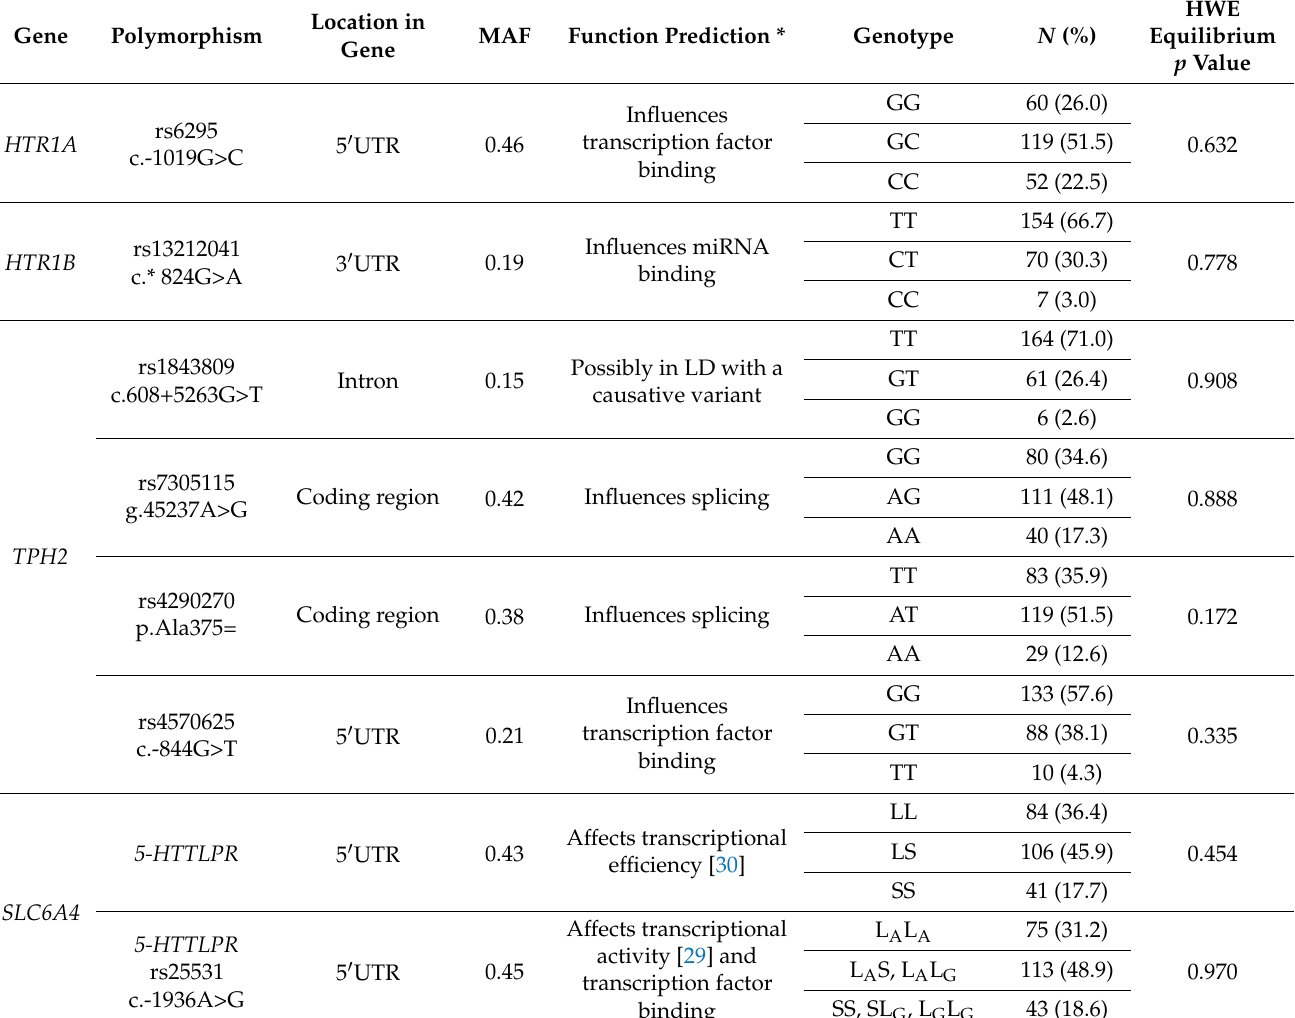
Table 1. Genotype frequencies and characteristics of the genetic variants studied in our Parkinson’s disease (PD)